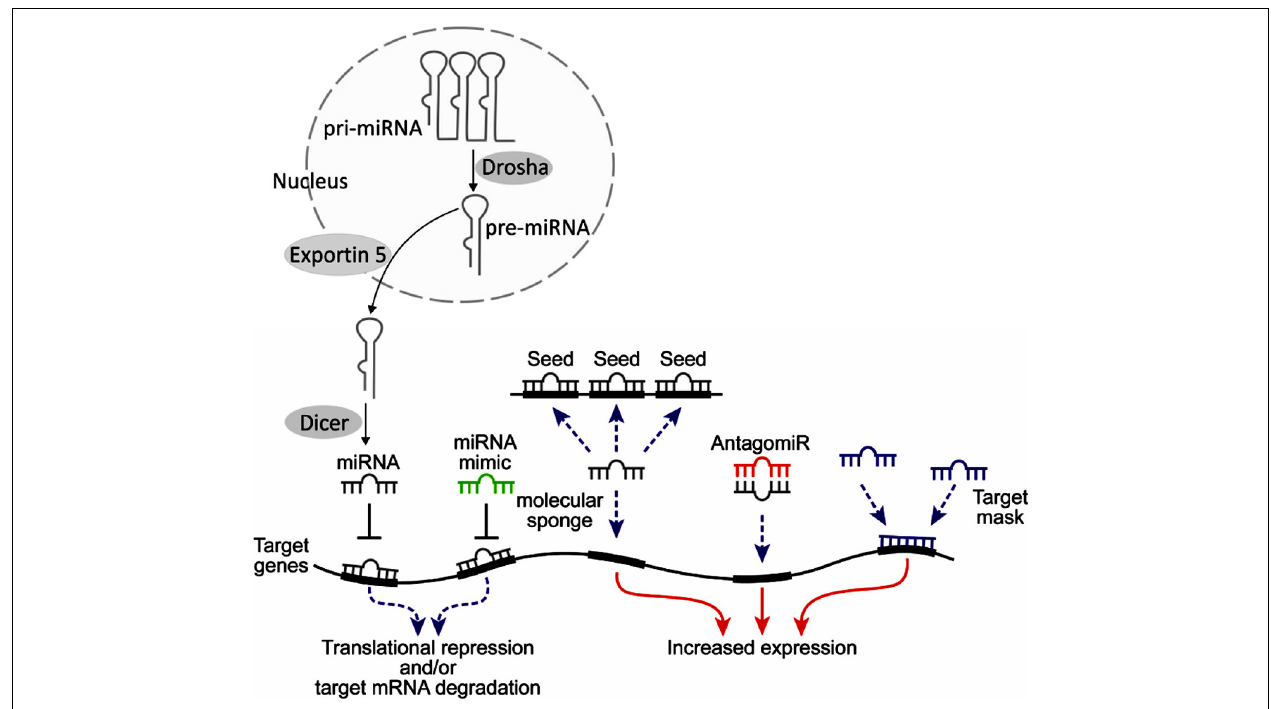
degradation. Mimicking this process, miRNA mimics (green) with similar sequences to those of miRNAs may be designed to target the same mRNAs. Such mimics are synthetic oligonucleotides that are chemically protected against nucleolytic degradation. Alternative routes include molecular “sponges,” with several binding sites of a certain miRNA; antagomiRs (red), complementary oligonucleotides to the host miRNA which bind to it and limit its function, and target masks, which bind to part of target miRNAs and compete with their function. Thus, tools exist both for inducing gain of function (red arrows) or loss of function (dashed blue